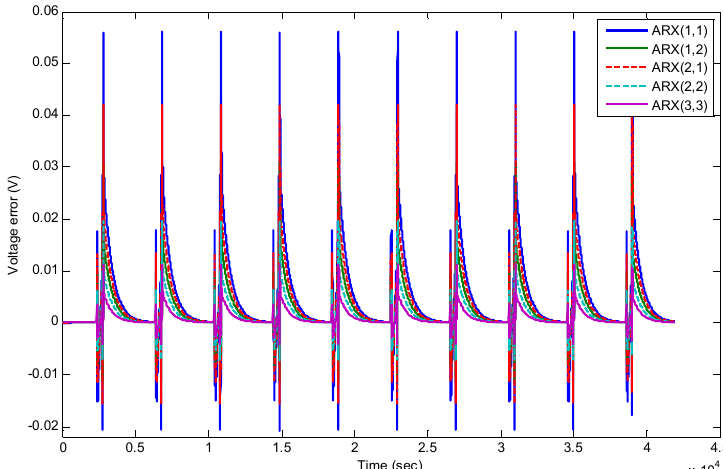
Figure 12. The terminal voltage error curves between the simulation and experiment.